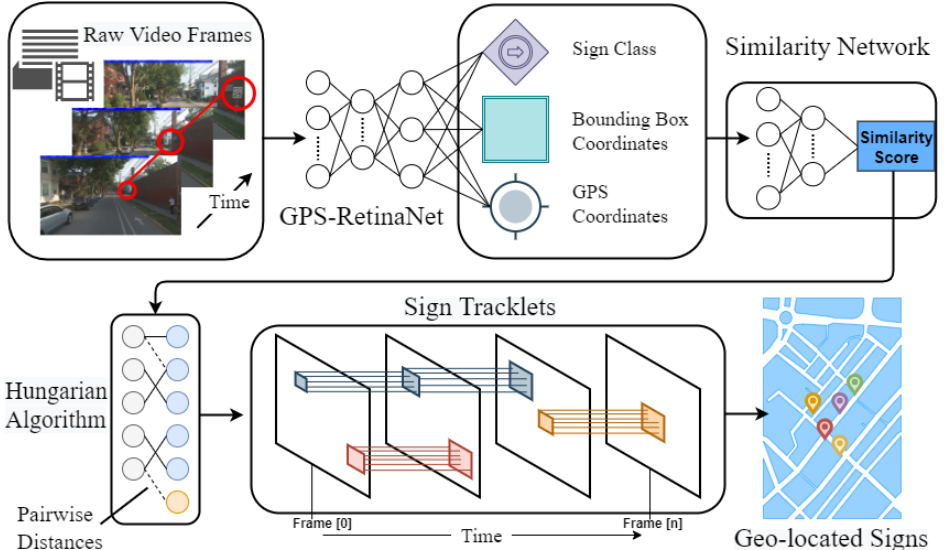
Figure 5. An overview of the Sign Hunter pipeline. First, raw images extracted from videos of a road vehicle (top-left) are fed into GPS-RetinaNet (top-middle) which detects, classifies, and predicts signs’ GPS offsets. Pairs of detections output by GPS-RetinaNet are provided as input to the similarity network (top-right), which quantifies the similarity between the signs. The Hungarian algorithm [32] (bottom-left) uses the similarity scores to merge repeated occurrences of objects, which forms tracklets (bottom-middle) containing all the occurrences of each object in the dataset. These tracklets are condensed into final sign predictions to create a GIS map (bottom-right) of sign